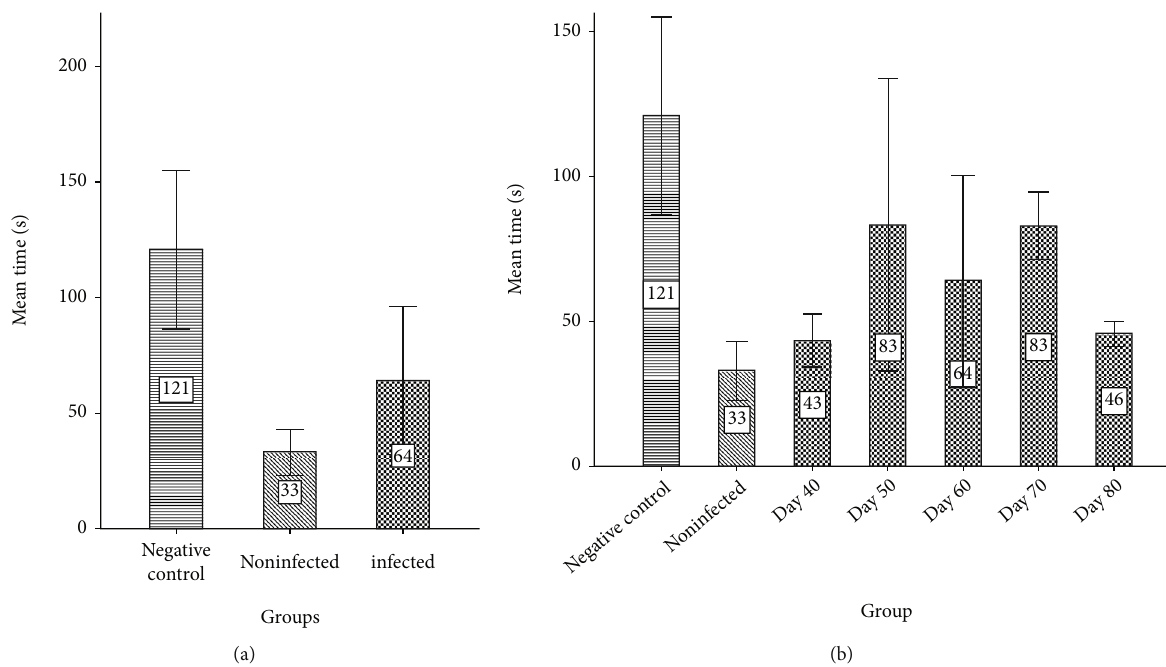
Figure 5: (a) The average running time of the mice in the rotarod test in negative control, PD uninfected mice, and PD mice infected with Toxoplasma . (b) The average running time of the PD mice infected with Toxoplasma at days 40, 50, 60, 70, and 80 in comparison with negative control and PD uninfected mice.